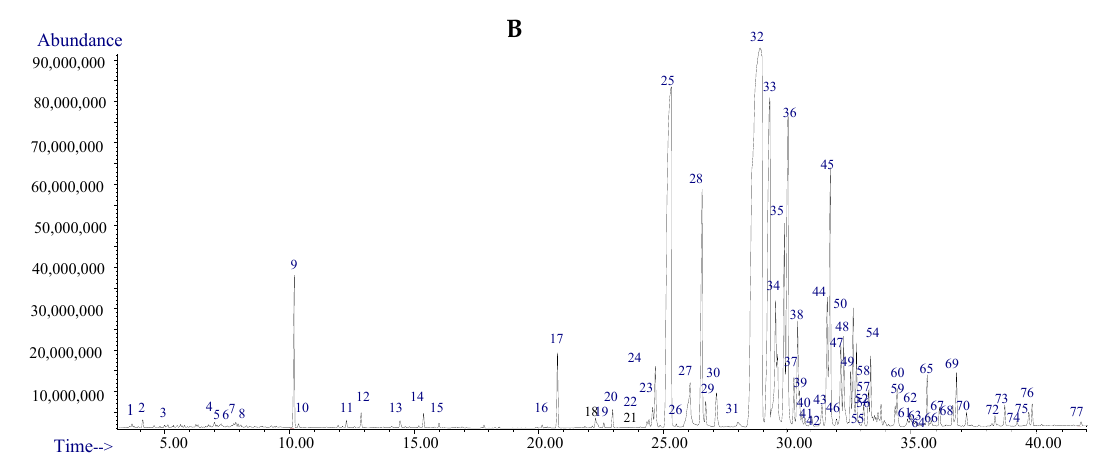
Figure 3. Total ion current chromatogram of TDS ( A ) and the volatile extract of whole body powder ( B ).